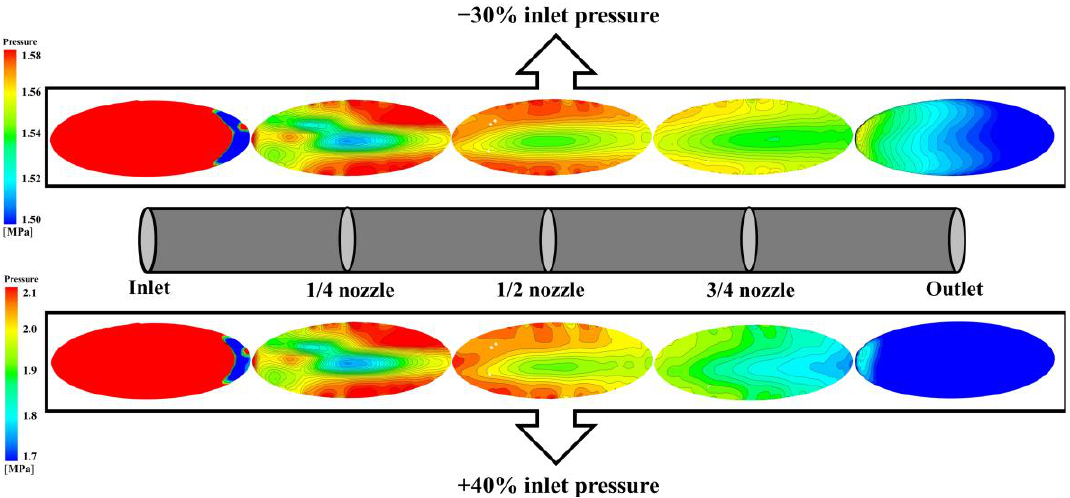
Figure 10. Pressure distribution in the pre-swirl nozzle at different axial positions ( Re = 9.5172 × 10 5 ). Figure 11 reflects the variation of 𝐶 𝑑 versus 𝑝 𝑖𝑛,𝑡𝑜𝑡𝑎𝑙 for the pre-swirl nozzle at four different Reynolds numbers. These values show an increasing trend versus 𝑝 𝑖𝑛,𝑡𝑜𝑡𝑎𝑙 . The maximum relative increment is up to 2% when Re increases from 2.39 × 10 5 to 9.5172 × 10 5 at a fixed 𝑝 𝑖𝑛,𝑡𝑜𝑡𝑎𝑙 .